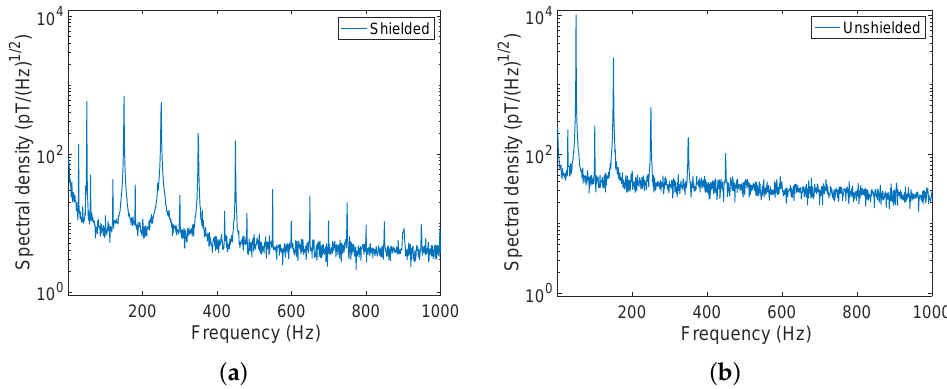
Figure A3. Fourier transforms of one-second time traces taken using a Bartington MAG690 magne- tometer in ( a ) shielded and ( b ) unshielded